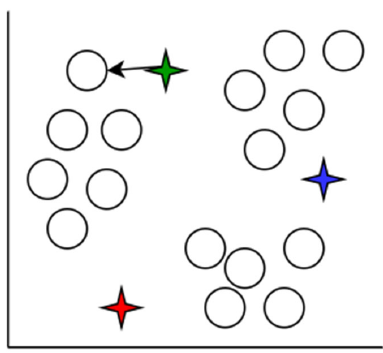
Figure 6. Step 3— K -means: K = 3 Step 3: Group data point to their nearest centroid by measuring the distance from each centroid using Euclidean Distance formula: 𝑑(cid:4666)𝑥 , 𝑦(cid:4667) (cid:3404) (cid:3493)∑ (cid:4666)𝑦 (cid:3036) (cid:3398) 𝑥 (cid:3036) (cid:4667) (cid:2870)(cid:3041) (cid:3036)(cid:2880)(cid:2869) Distance between data point X and Centroid C can be calculated using the